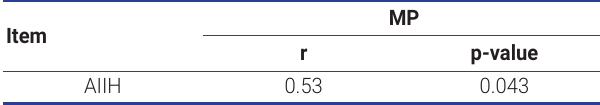
Table 16. Correlation study between FTIR protein structures and the Table 18. Correlation study between FTIR protein structures of can- protein portions of the in vitro of canola meals ola meals and the NRC model IDP (%RUP) MP Item Item r 0.043 FTIR, Fourier transform infrared; AIIH, amide II height; IDP, intestinal FTIR, Fourier transform infrared; NRC, National Research Council; MP, digestibility of protein; r, correlation coefficient using Spearman. metabolizable protein; AIIH, Amide II height; r, correlation coefficient using Spearman. Table 17. Correlation study between FTIR protein structures and the Table 19. Correlation study between FTIR protein structures of Can- protein portions of the in vitro of canola seeds ola seeds and the NRC model dBDM (%) IADP (g/kg DM) AECP ECP Item Items r p-value r p-value r p-value 0.009 FTIR, Fourier transform infrared; dBDM, digestibility of bypass dry matter; IADP, intestinally absorbable feed protein; Ratio, ratio of α-helix: β-sheet; r, correlation coefficient using Spearman. <0.001 FTIR, Fourier transform infrared; NRC, National Research Council; AECP, truly absorbed ECP in the small intestine; ECP, endogenous protein in the small intestine; Peak area, Amide I and II peak area; AII, Amide II area; AIH, Amide I height; AIIH, Amide II height; Alpha, α-helix height; Ratio, ratio of α-helix: β-sheet; r, correlation coefficient using